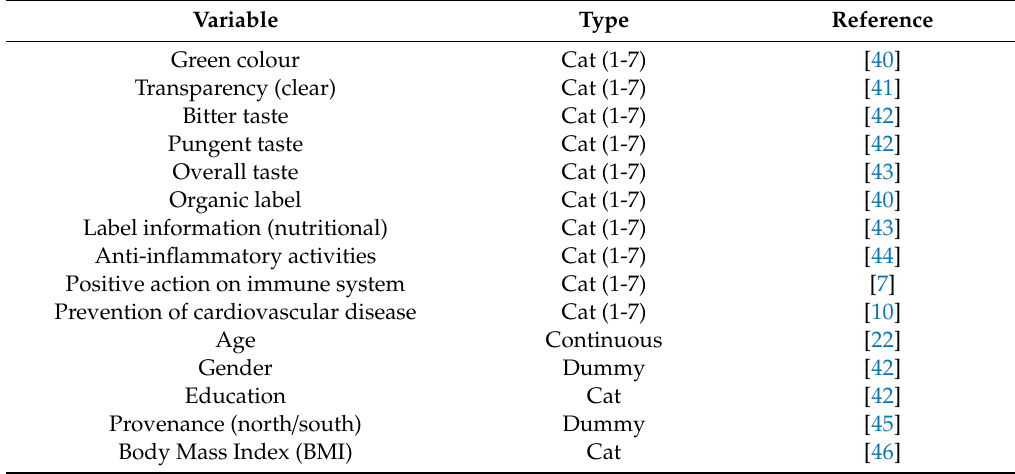
Table 2. Tested attributes and socio-economic characteristics of the